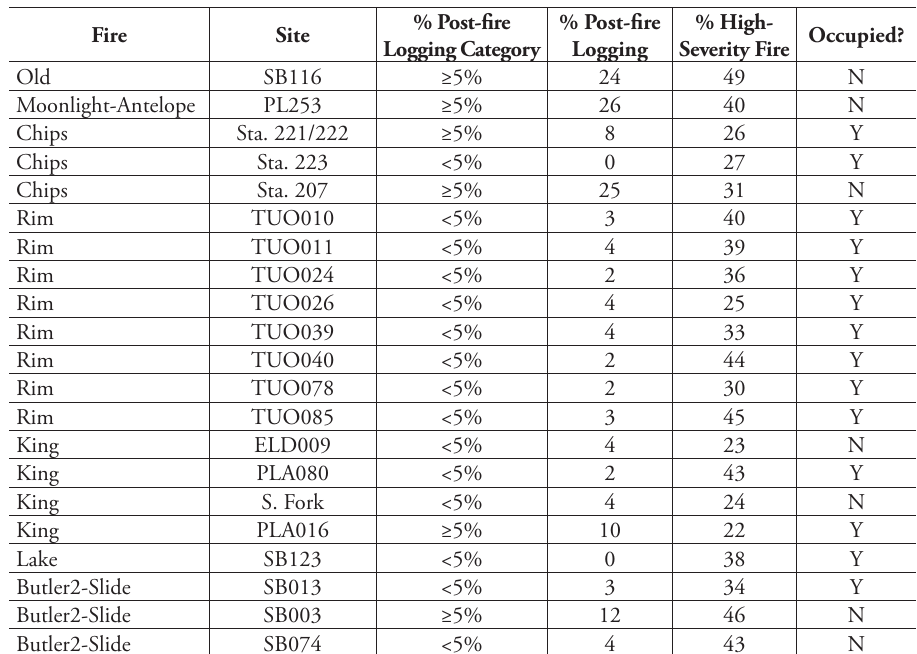
Table 2. Occupancy of California spotted owl sites with 20-49% high-severity fire. Sites have varying levels of post-fire logging, within a 1500 m radius of territory centres, in large fires >10,000 ha in size since 2001. Within each fire, all sites were occupied in a single survey year prior to post-fire logging.